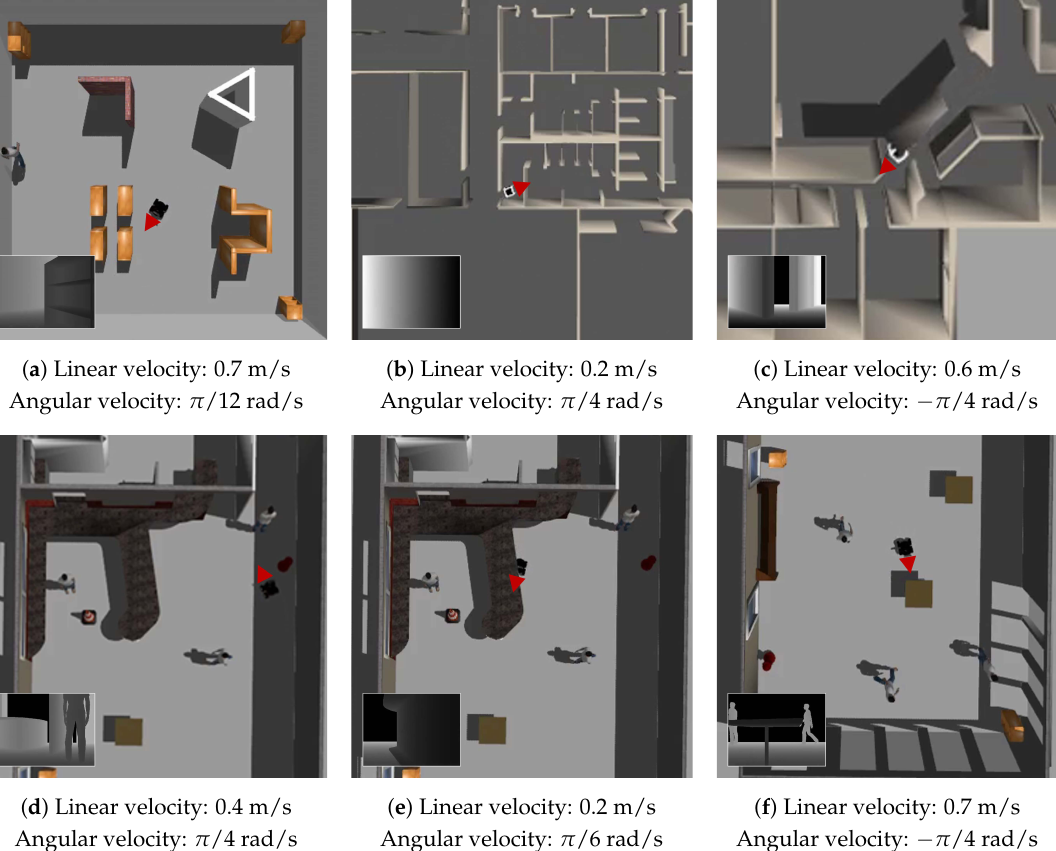
Figure 6. Sample velocity commands produced by the BND-DDQN model based on the estimated Q-values in various scenarios. In each example, the orientation of the mobile robot is highlighted using a red triangle and the raw depth image is shown in the bottom left corner